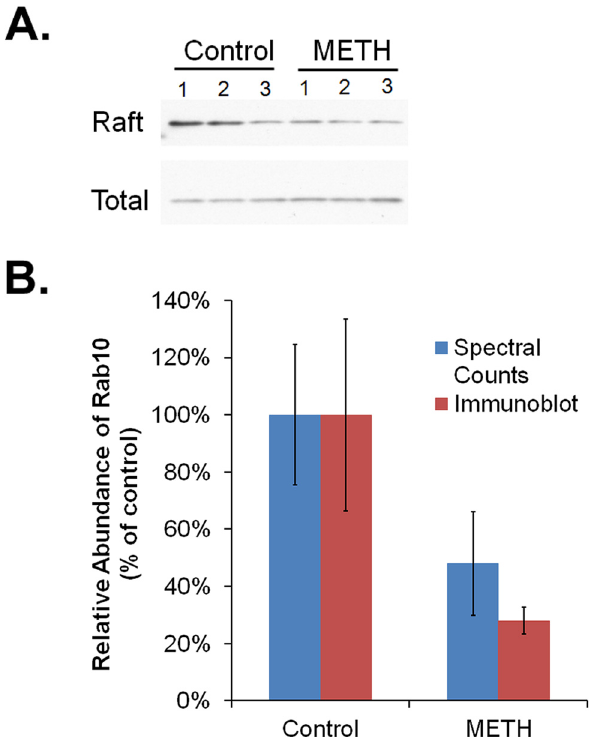
Fig 2. Decreased Rab10 localization in raft fractions following methamphetamine treatment. (A) Immunoblot analysis of Rab10 abundance in striatal membrane raft fractions (Raft) and total homogenates (Total) from rats treated with methamphetamine (2 mg/kg, i.p.; METH) or saline (Control), followed by density gradient centrifugation to separate raft from non-raft samples. (B) Spectral counting data for Rab10 and densitometric analysis of the immunoblots (optical density). Densitometry of Rab10 was normalized to Rab10 in total homogenates. Results shown are the mean ± SEM, expressed as a percentage of the mean control value. For spectral counting, p < 0.05 and t = 5.18 (unpaired two-tailed Student ’ s t-test, n = 4). For immunoblot densitometry, p = 0.10 and t = 2.92 (unpaired two-tailed Student ’ s t-test, n = 3).